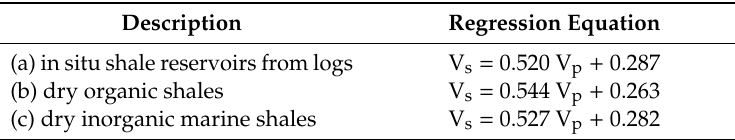
Table 4. Shear-wave velocity (V s ) versus compressional-wave velocity (V p ) relationships. From ( a ) measured velocity logs in organic shale reservoirs, ( b ) bedding normal laboratory measurements in dry organic shales, and ( c ) bedding normal laboratory measurements on dry inorganic shales from the o ff shore Gulf of Mexico. The laboratory measurements are from [9]. Velocities are in units of km /